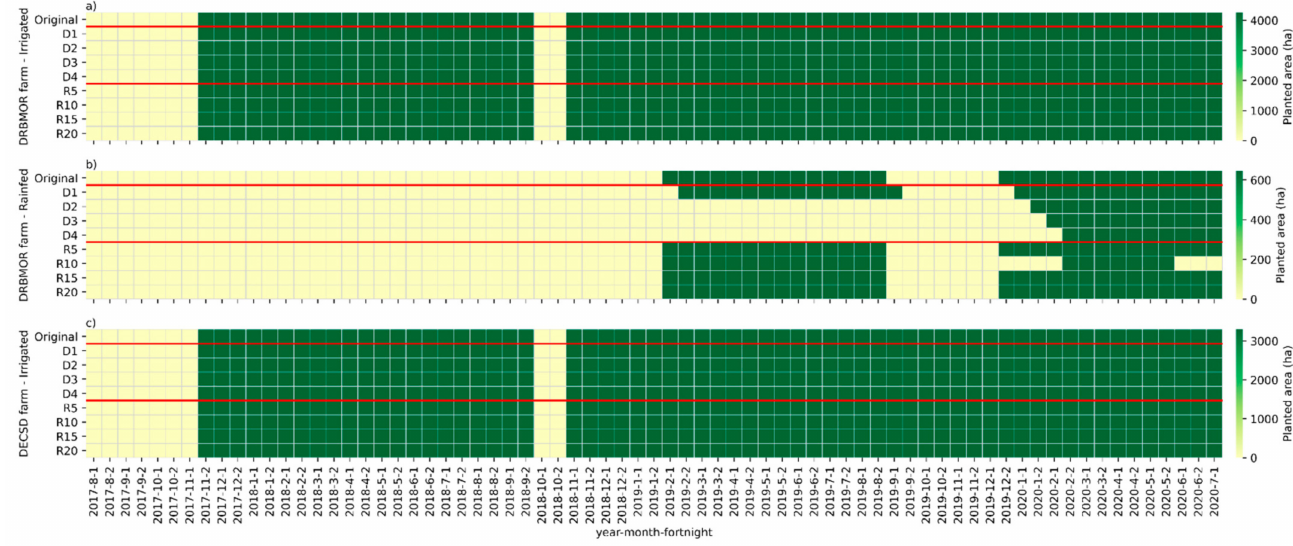
Figure 6. Planted area, in hectares, recommended by LPM application at DRB MOR and DECSD farms. ( a ) Shows the results for irrigated areas of DRBMOR farm. ( b ) Shows the results for rainfed areas of the DRB MOR farm. ( c ) Shows the results for irrigated areas of DECSD farm. At the Busato farm, in irrigated areas, the LPM recommends a double-cropping system composed of cotton and maize second crops for all occasions of rainfall delay or